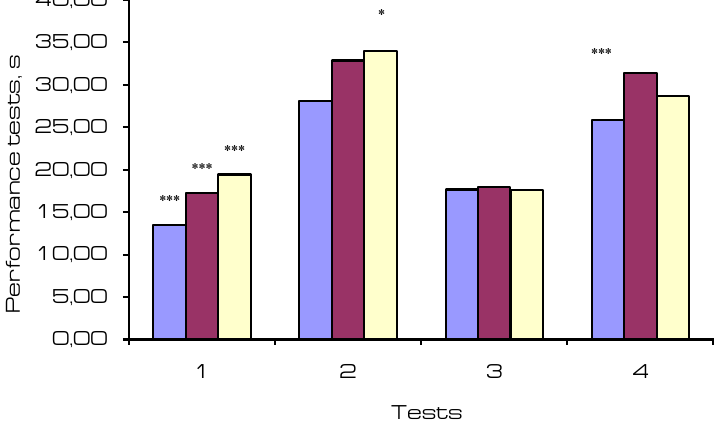
Fig.4. Indicators of test for special physical fitness of elite sportsmen, who specialize in speed rock-climbing (n=10), complex rock-climbing (n=10) and mountaineering